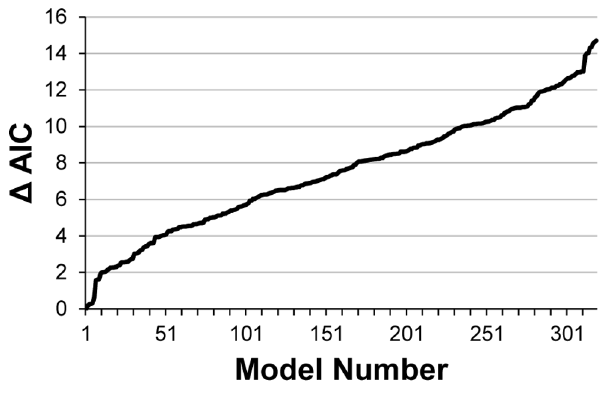
Figure 5. Change in AIC among AIC-ranked models considered in multimodel inferences of walrus resource